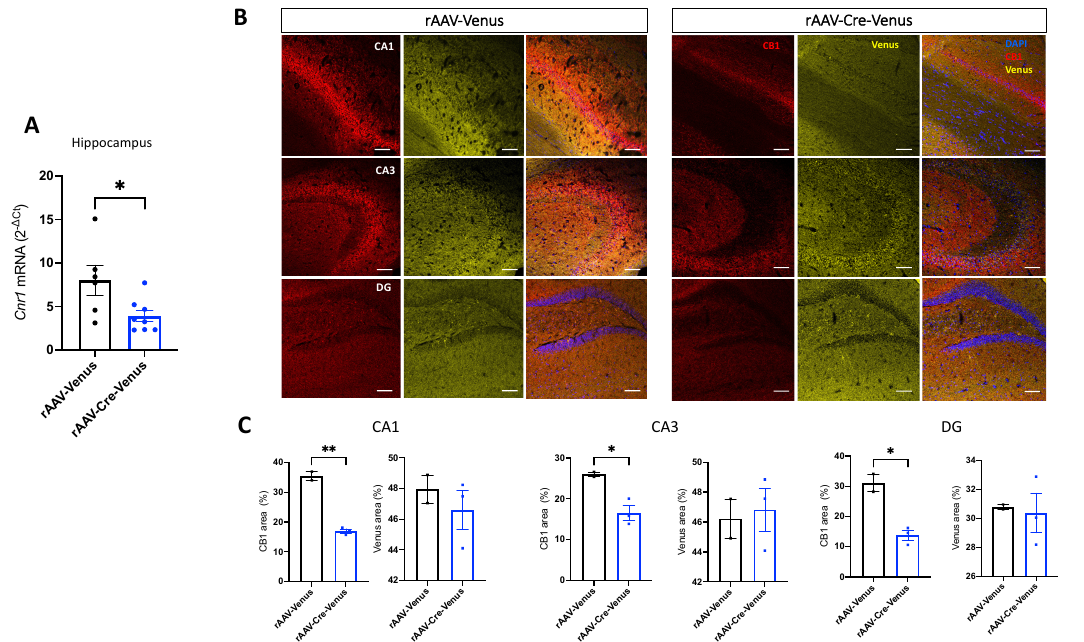
Figure 1. ( A ) mRNA expression levels of Cnr1 in the hippocampus. ( B ) Confocal microscopy pictures representing the CB1 (red), Venus (yellow) and DAPI (blue) immunofluorescence and ( C ) quantification of the CB1-IR and Venus positive areas in the cornu ammonis 1 (CA1), cornu ammonis 3 (CA3) and dentate gyrus (DG) hippocampal regions of 6-month-old rAAV-Cre-Venus and rAAV-Venus (control) injected CB1 flox/flox mice. Scale bar 100 µ m. Individual data points, mean value ± SEM are shown. Student’s unpaired t -test. * p < 0.05; ** p <